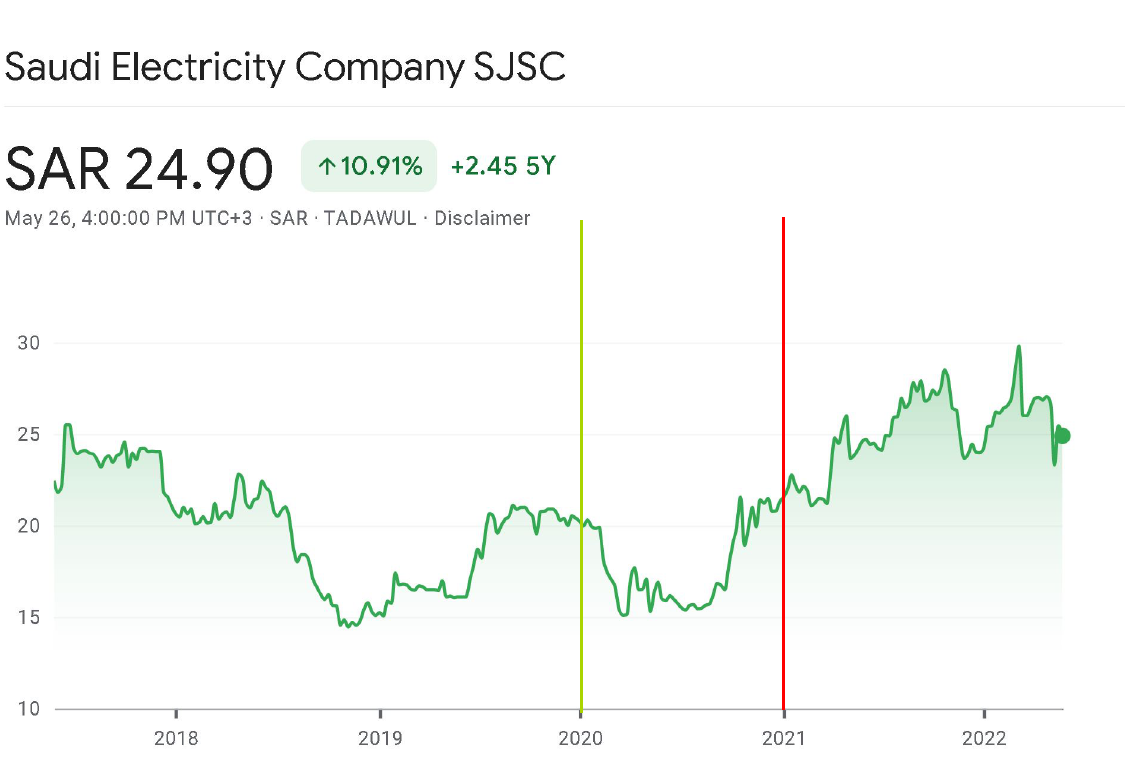
Figure 6. Behaviour of Saudi Electricity Company (5110) during the training and testing periods.